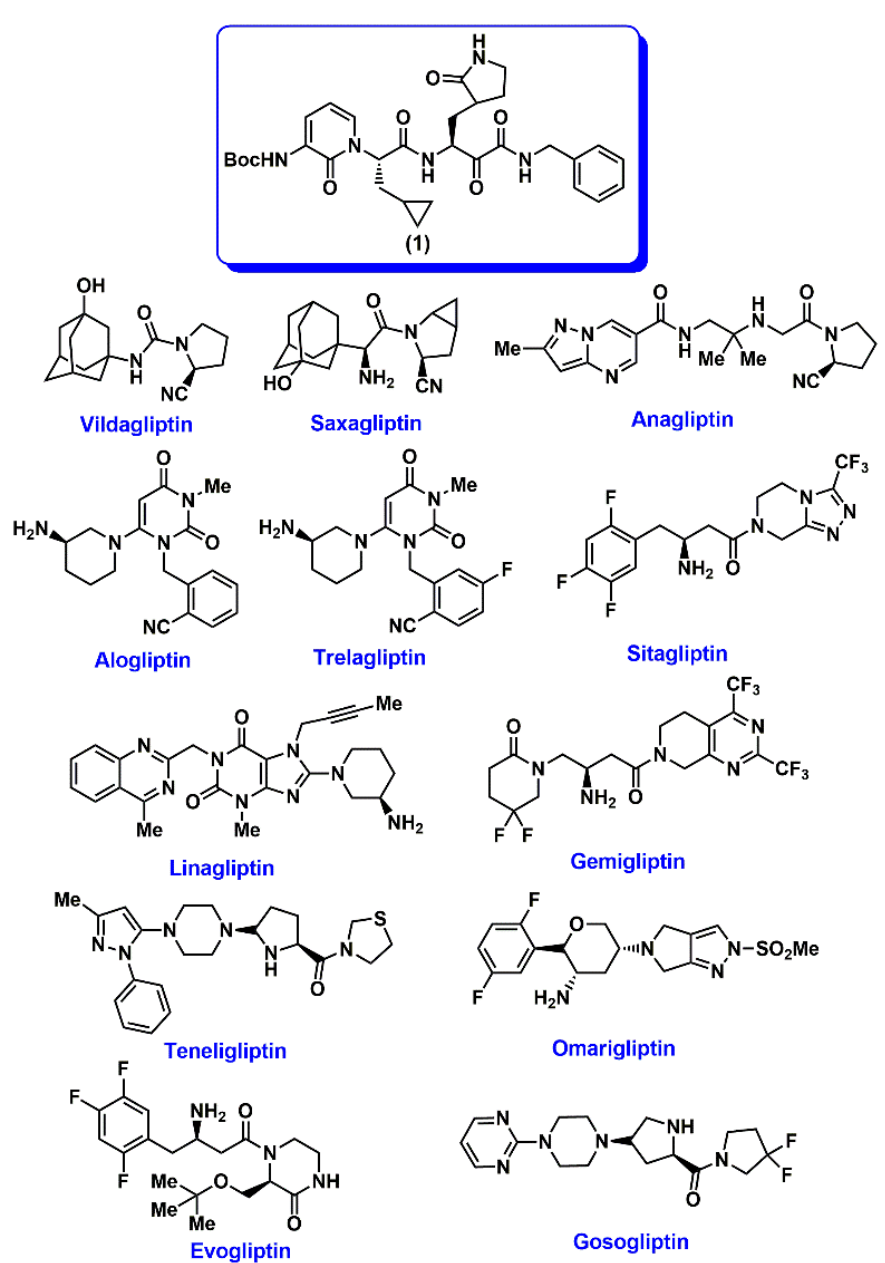
Figure 1. Chemical structures of SARS-CoV-2 M pro inhibitor 1 and DPP4 inhibitors used in this study.